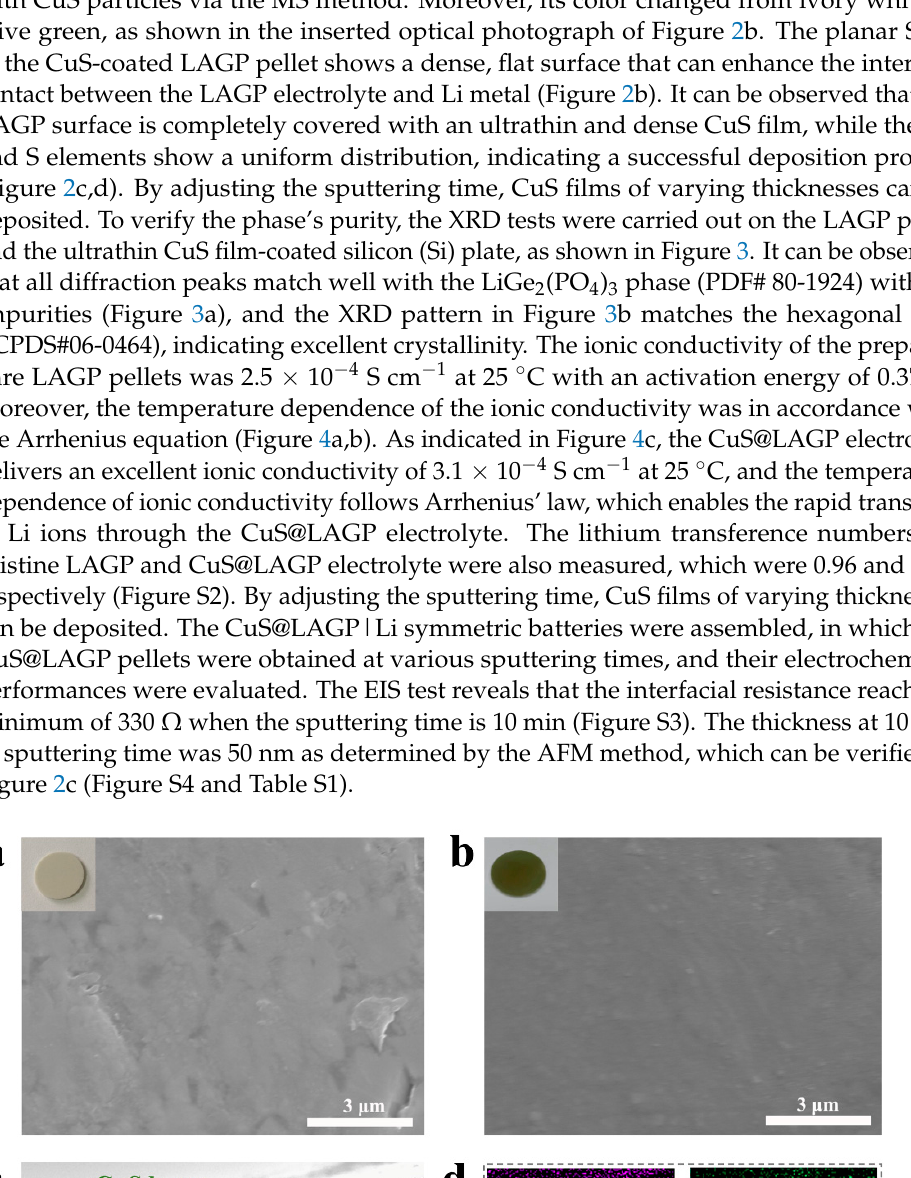
Figure 3. XRD patterns of the ( a ) LAGP pellet and ( b ) CuS film deposited on the Si plate.